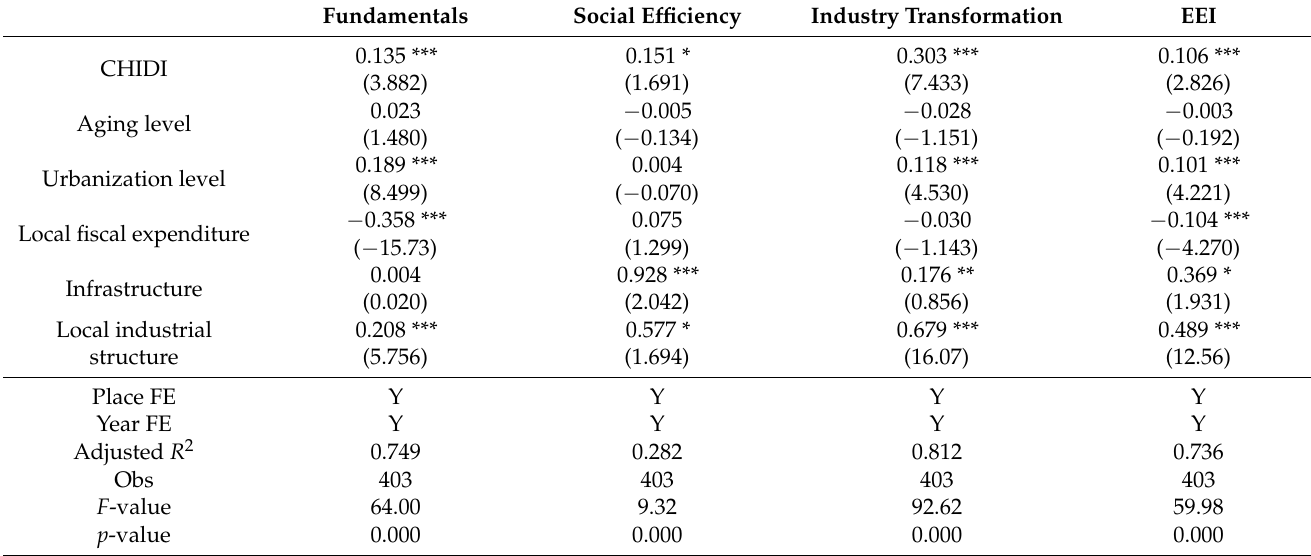
Table 3. Baseline